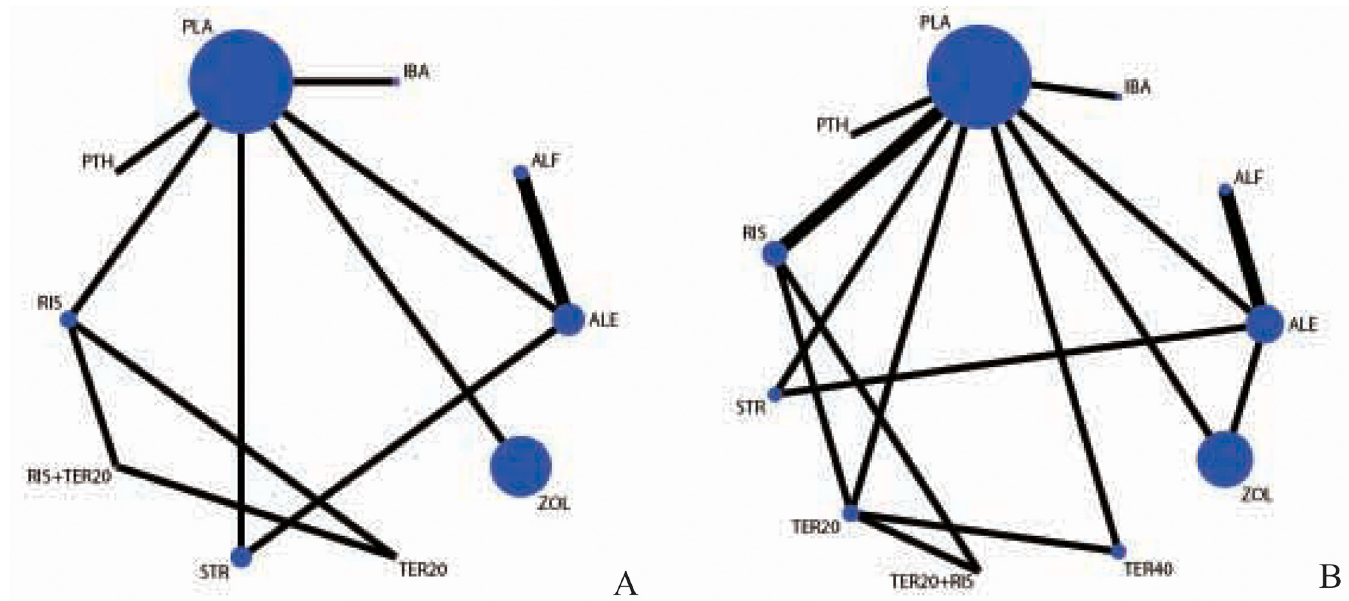
Fig 3. Network of treatment comparisons. The size of the nodes represents the total sample size of treatments. The lines ’ thickness corresponds to the number of trials that compare each other. Panel A: Network of treatment comparisons for the BMD in LS. Panel B: Network of treatment comparisons for the fracture rate. ALE: Alendronate; PLA: Placebo; ALF: Alfacalcidol; RIS: Risedronate; IBA: Ibandronate; ZOL: Zoledronate; STR: Strontium Ranelate; TER: Teriparatide; PTH: Parathyroid Hormone.